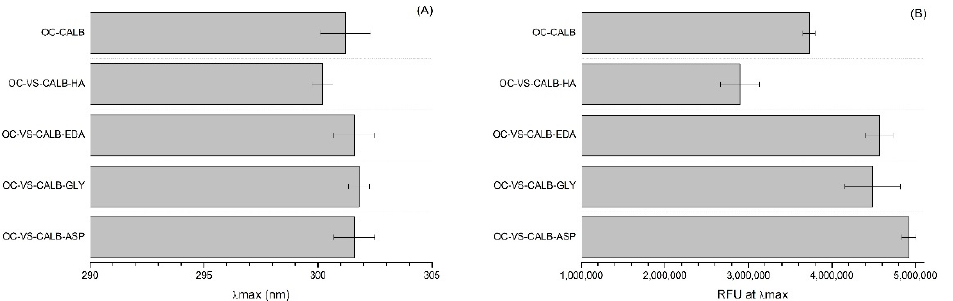
Figure 7. Intrinsic protein spectra of CALB biocatalysts blocked with different blocking reagents. Other specifications may be found in Methods section.